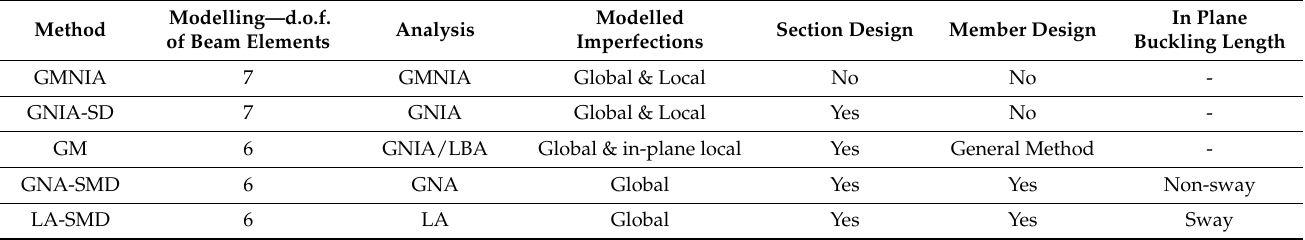
Table 1. Key features of the examined